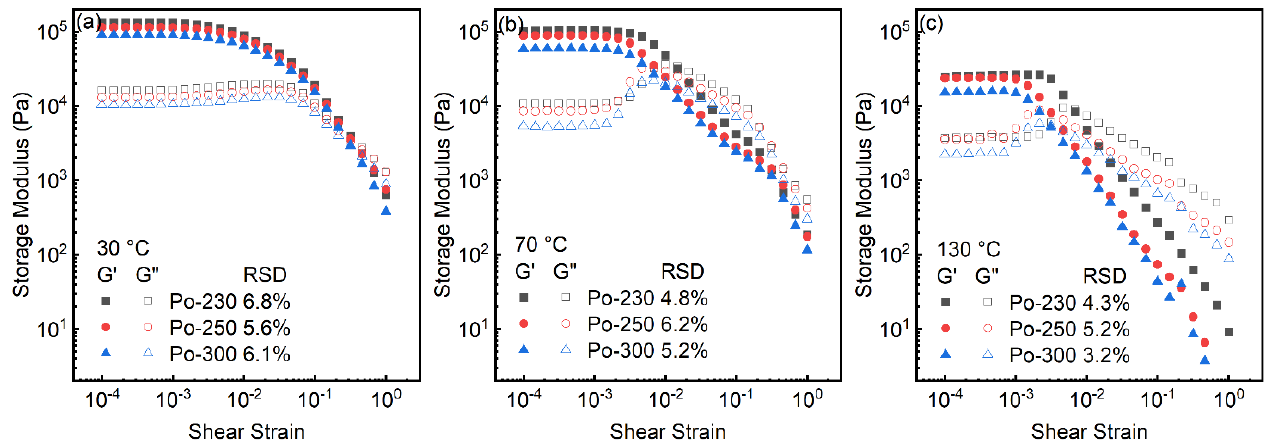
Figure 8. Strain-scanning curves of polyurea grease with different consistencies at different temper- atures: ( a ) 30 °C, ( b ) 70 °C, ( c ) 130 °C.